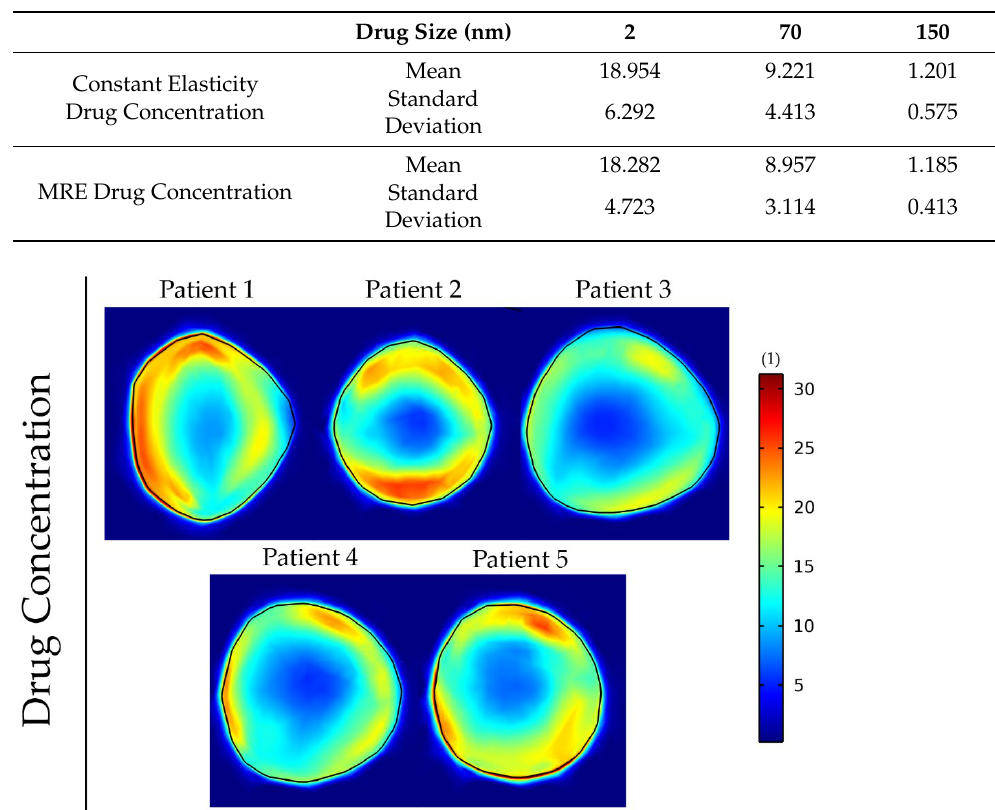
Figure 8. Drug concentration taken up by cancer cells for various drug sizes. A comparison among the isotropic-constant elastic properties case and the anisotropic-elastography case (patient 1) is shown. All results are displayed at day 43 of the simulation following a drug injection at day 41. The vessel wall pore size was set to 200 nm. Table 3. Mean and standard deviation values of the drug concentration inside the tumor domain of the 6 cases of Figure 8.